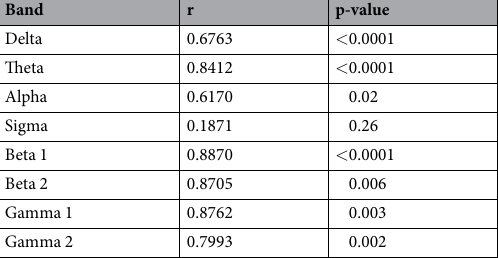
2 and shared environmental Figure 5. Heritability estimated by means of Falconer’s formula = − h r r 2( ) MZ DZ 2 2 2 for NREMS and REMS. Data from the first contributions calculated from = − = − c r h r h /2 MZ DZ assessment (time 1) are shown as a dashed line and data from the second assessment (time 2) as a solid line. REMS is shown in maroon while NREMS is in teal. Band